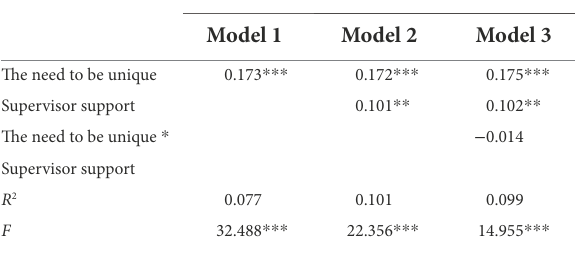
TABLE 2 Regression